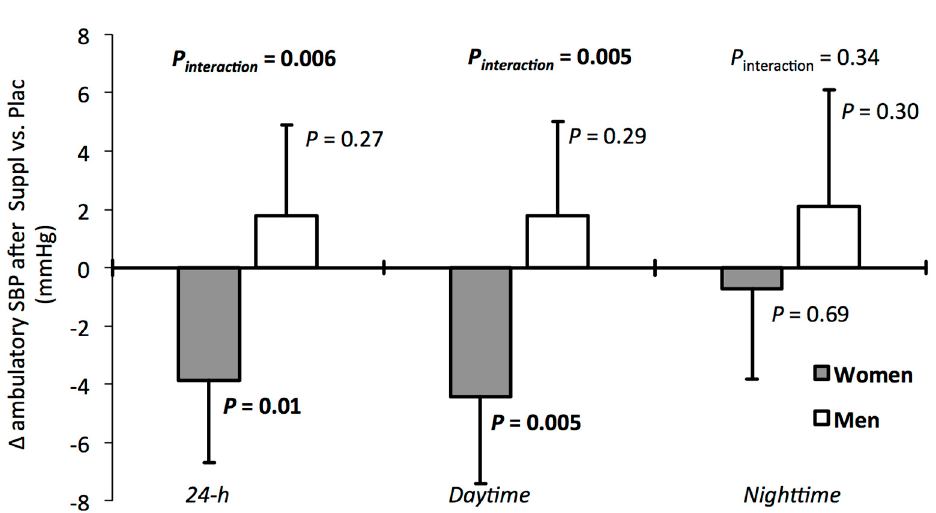
Figure 2. Changes in ambulatory systolic blood pressure (SBP) in response to the polyphenol extract and L-citrulline supplement (Suppl) compared to placebo (Plac) according to sex. Results are shown as differences in least-squares means (Suppl vs. Plac) with 95% CIs obtained from the GENMOD procedure. For men and women, respectively: Plac, n = 14 and n = 20; Suppl, n = 16 and n = 19. SBP, systolic blood pressure.